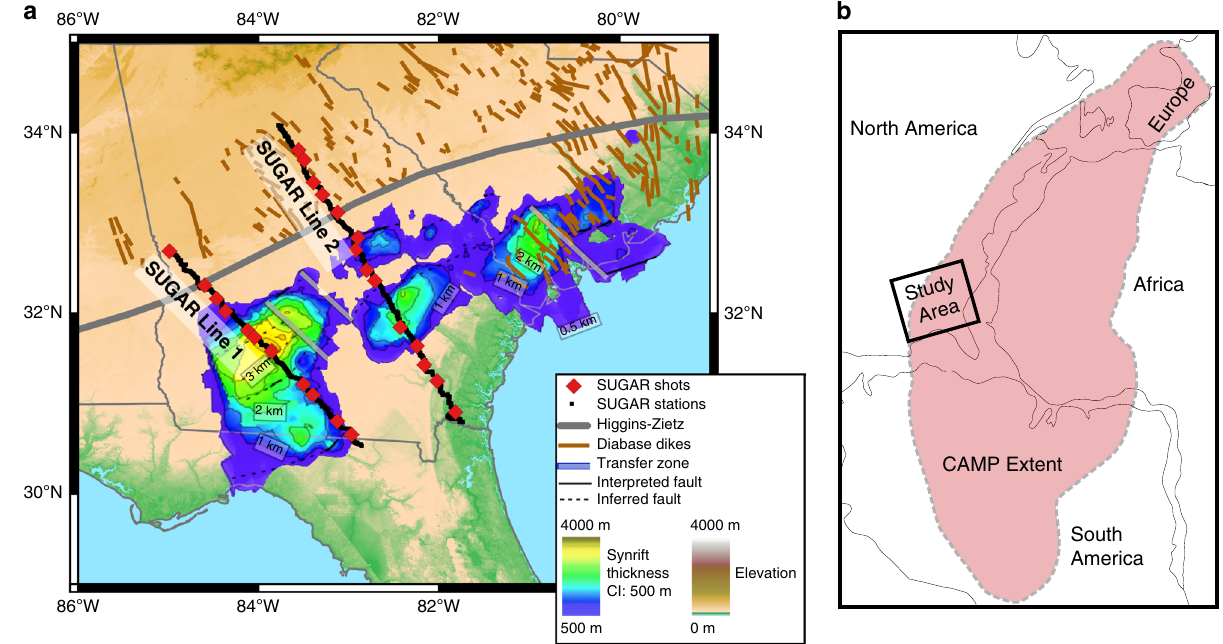
Fig. 1 Map of the South Georgia Rift Basin in the southeastern United States. a Locations of Lines 1 and 2 from the SUGAR refraction seismic experiment, the Higgins-Zietz magnetic boundary interpreted as the Alleghanian suture 38,69 , CAMP dikes mapped via magnetic data 50 and fi eld observations 51 , and the isopach map of synrift sedimentary fi ll in the South Georgia Basin constrained by well and seismic re fl ection and refraction data 49 . SUGAR seismic shots are indicated with red diamonds and receivers are shown with the dark line beneath the shots. b The approximate extent of CAMP shaded in red over a reconstruction of Pangea 18 .